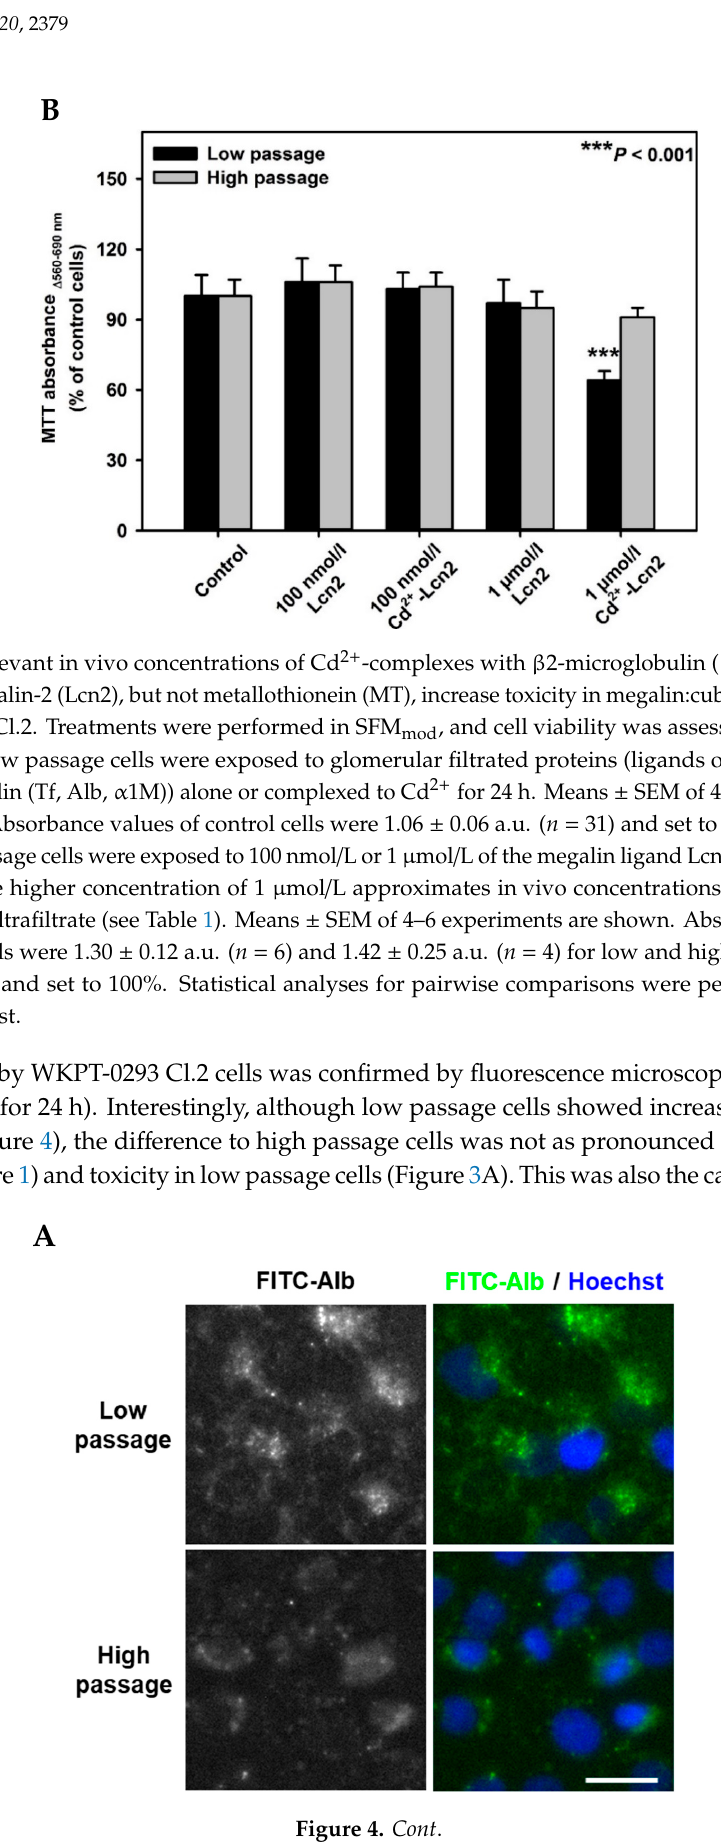
Figure 4. Uptake of FITC-albumin (Alb) in low and high passage WKPT-0293 Cl.2 cells. ( A ) Cells were exposed to 100 nmol/L FITC-Alb (green) in SFM mod for 24 h. Subsequently, cells were fixed, and mounted for fluorescence imaging. Nuclei were counterstained with Hoechst 33342 (blue). The experiment is representative of four similar ones. Scale bar = 20 µm. ( B ) Fluorescence intensity was analyzed in 83–238 cells (dots) from 4 different experiments (colors). For details of box plot statistics, see Section 4.2. Statistical analysis compared the low and high passage cells by non-parametric one- way ANOVA (Kruskal-Wallis-Test, using Dunn’s post-hoc analysis. 3. Discussion